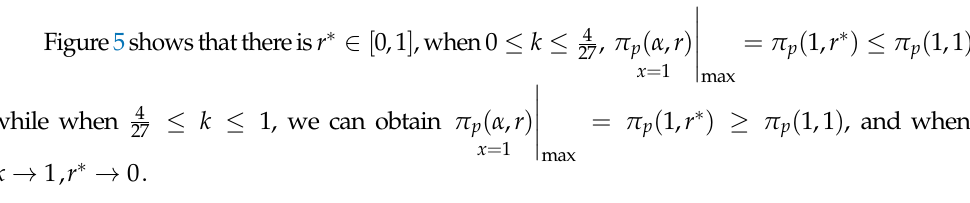
Figure 5. Platform’s revenue as commission rate changing when the consumer groups privacy is